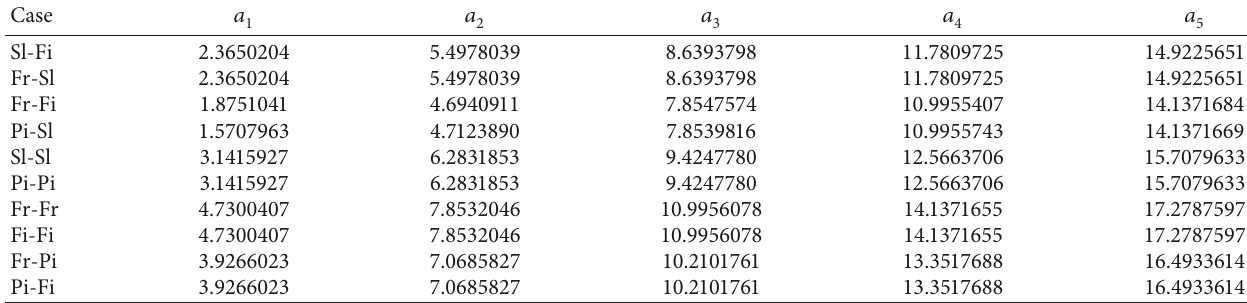
��� 􏽰 ζω ) for ten degenerate cases with κ �